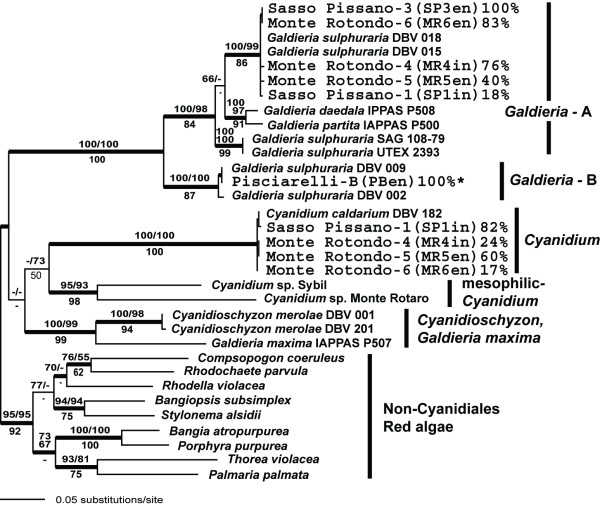
Phylogeny of the Cyanidiales inferred from a maximum likelihood (ML) analysis using the site-specific GTR evolutionary model and rbcL sequences. Results of the ML-all bootstrap analysis are shown above the branches on the left of the slash mark, whereas the results of the bootstrap analysis of ML-1st + 2nd data set are shown on the right of the slash mark. The results of the protein maximum likelihood bootstrap analysis using the JTT + Γ model are shown below the branches. Only bootstrap values ≥ 50% are shown. The thick nodes represent ≥ 95% Bayesian posterior probability for clades using the site-specific GTR model. The sequences arising from a previous study [6] are marked with asterisks. The percentage values shown for each sampling site indicate the proportion of Cyanidiales members that were recovered in the different PCR-based environmental libraries. About 20 clones were sampled from each site (for the actual number, see Table 1).